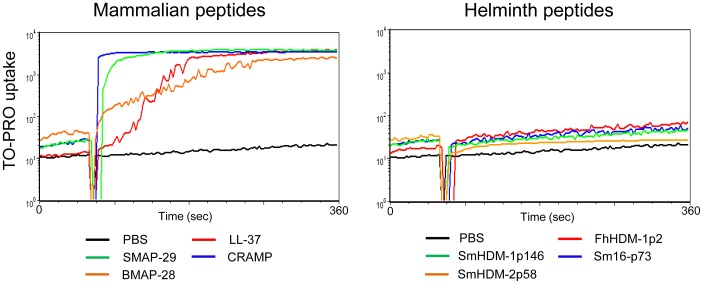
Mammalian, but not helminth, peptides induce the formation of pores in macrophages.RAW macrophages were incubated in the presence of TO-PRO. After 60 sec, 50 µM of mammalian (left panel) or helminth (right panel) peptides was added to the medium. The uptake of fluorescent dye was measured over a period of 360 sec.